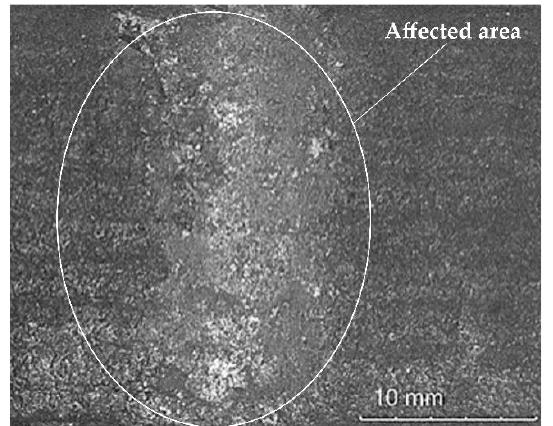
Figure 17. Macrostructure of the affected area. Condition of the surface of the composite layer (PPTAW metal deposition method, Co3+TiC+PD-W composite powder) deposited on structural low-alloy steel AISI 4715 after impact resistance tests.